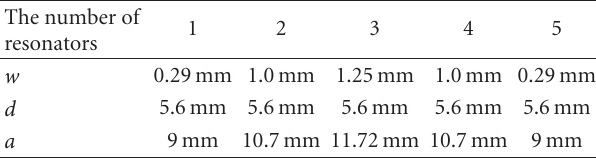
Table 3: The geometrical parameters of the